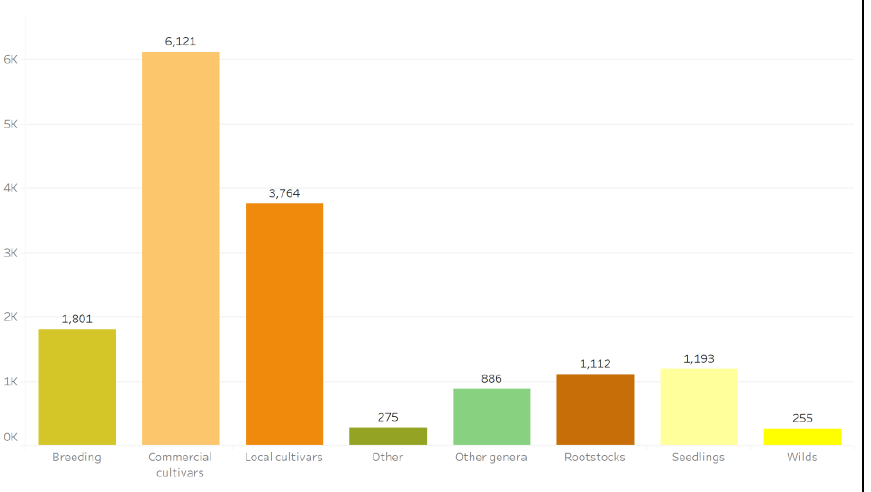
Figure 3. The number of ex situ citrus plant genetic resources reported in all survey responses that are classified in the listed categories.